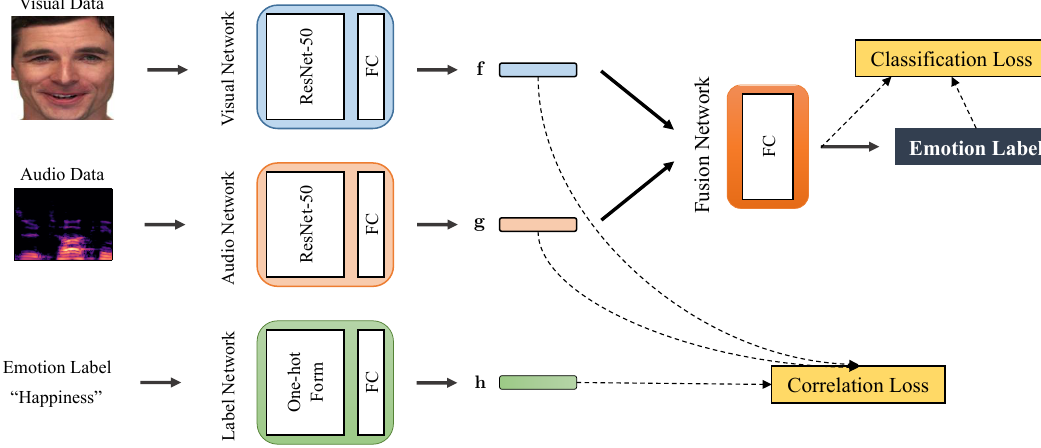
Figure 1. The structure of our proposed system for audio-visual emotion recognition. The full loss function of our framework is a linear combination of correlation loss and classification loss. Audio network and visual network use ResNet-50 [37] as the backbone architectures. Fusion network has several fully connected layers. Different settings of fusion network are considered in Section 5.2.2. The correlation loss is used to extract common information between different modalities. Additionally, the classification loss is used to capture discriminative information from each modality for emotion prediction. During the training process, emotion labels are used twice, once to compute the classification loss, and the another as the third modality to compute the correlation loss with audio and visual modalities. In this way, label information can be fully used in order to improve the discrimination ability of the feature representations. In the testing process, audio and visual data are used to predict the corresponding emotion